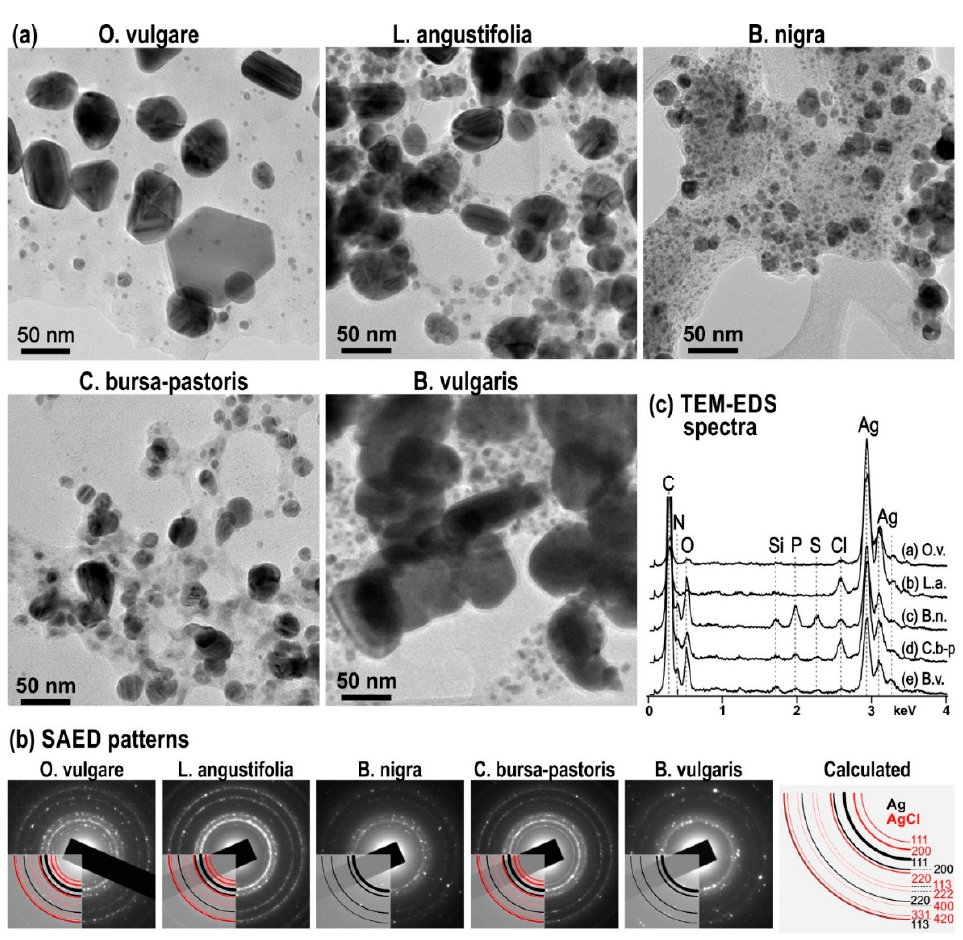
Figure 2. ( a ) The transmission electron microscopy (TEM) images of AgNPs in samples synthesised with different plant extracts from 5 mM AgNO 3 , ( b ) selected area electron diffraction (SAED) patterns of samples and calculated diffraction rings for Ag (black) and AgCl (red), and ( c ) TEM-EDS (energy-dispersive X-ray spectroscopy) spectra taken across areas of different samples including AgNPs and capping agents. Table 4. Relevant structural data for determination of Ag (ICDD-PDF2-065-2871) and AgCl